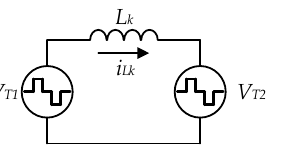
Figure 2. Converter simplified circuit intended for analysis.